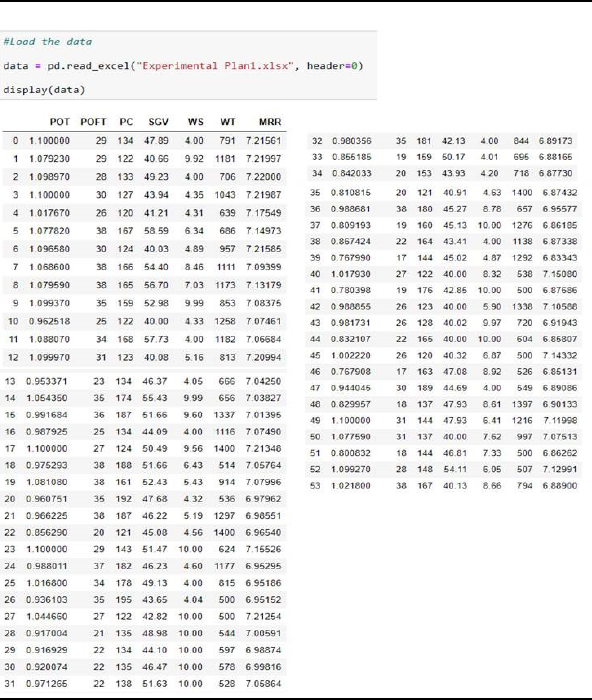
Table 5: Instruction to import the desirability values